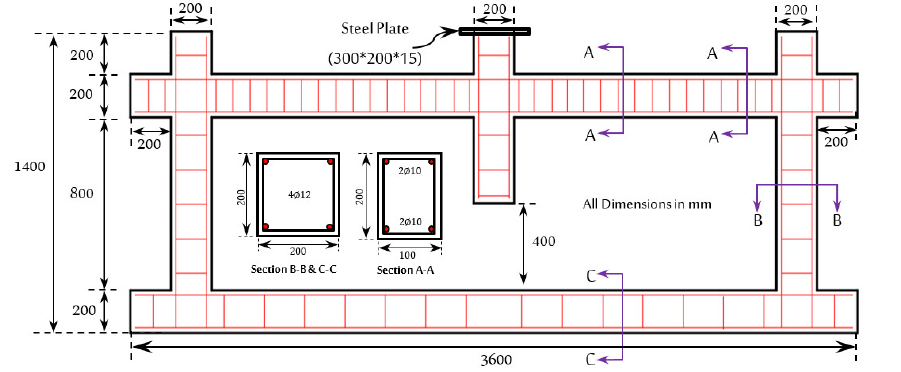
Figure 1. NC and RuC specimens details [47]. Table 1. Properties of NC and RuC mixtures